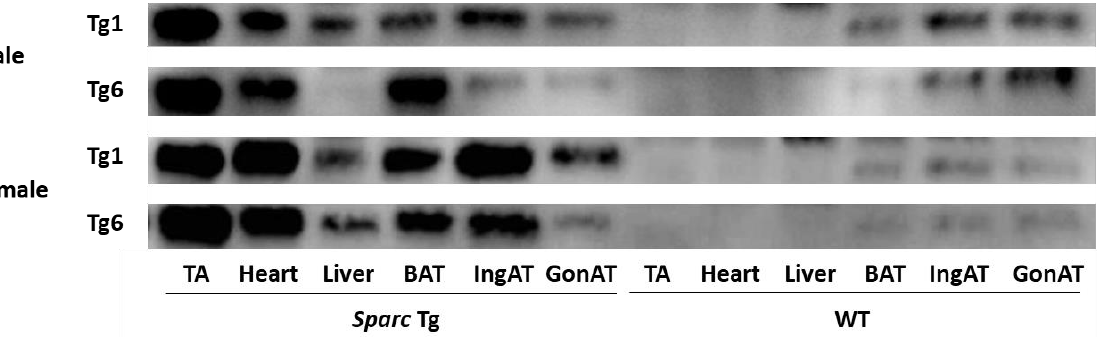
Figure 8. SPARC protein expression in the different tissues of transgenic ( Sparc overexpression) and WT of F1 and F2 mice. Abbreviations: BAT, brown adipose tissue; GonAT, gonadal adipose tissue; IngAT, inguinal adipose tissue; TA, tibialis anterior; Tg, transgenic ( Sparc overexpression); SPARC, secreted protein acidic and rich in cysteine; WT, wild-type.